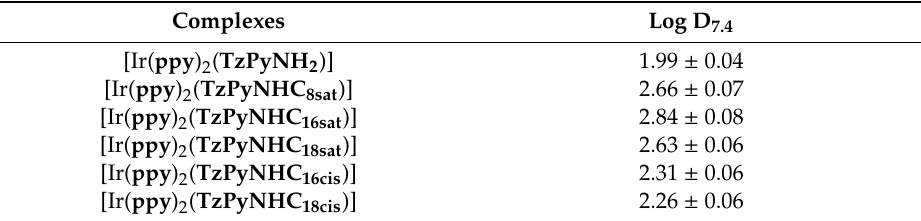
Table 2. Distribution coe ffi cient values (logD 7.4 ) for the reported iridium complexes.